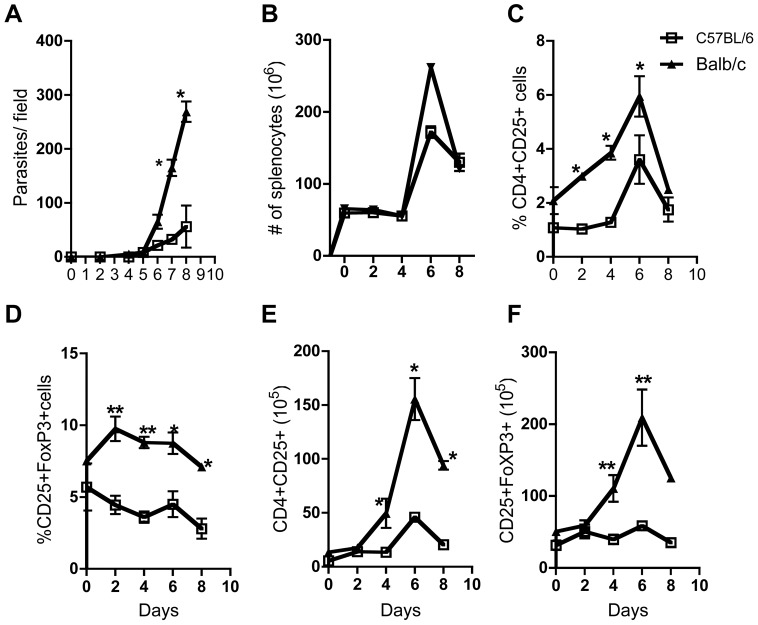
Expansion of Tregs in the highly susceptible and relatively resistant mice infected with T. congolense.Female C57BL/6 and BALB/c mice were infected with 103
T. congolense (clone TC13) intraperitonealy and parasitemia (A) was monitored daily by counting the number of parasites in a drop of tail blood under ×40 objective magnification. At indicated days, infected mice were sacrificed and the total number of cells (B) in the spleen was determined by trypan blue dye exclusion. Spleen cells were directly stained ex vivo and the percentage of CD4+CD25+ (C) and CD4+CD25+FoxP3+ (D) were determined by flow cytometry. The absolute numbers of CD4+CD25+ (E) and CD4+CD25+FoxP3+ (F) T cells were determined from the flow cytometric and cell count values. Results presented are representative of 3 independent experiments (n = 3 mice per group) with similar results. (*, p<0.05; **, p<0.01).